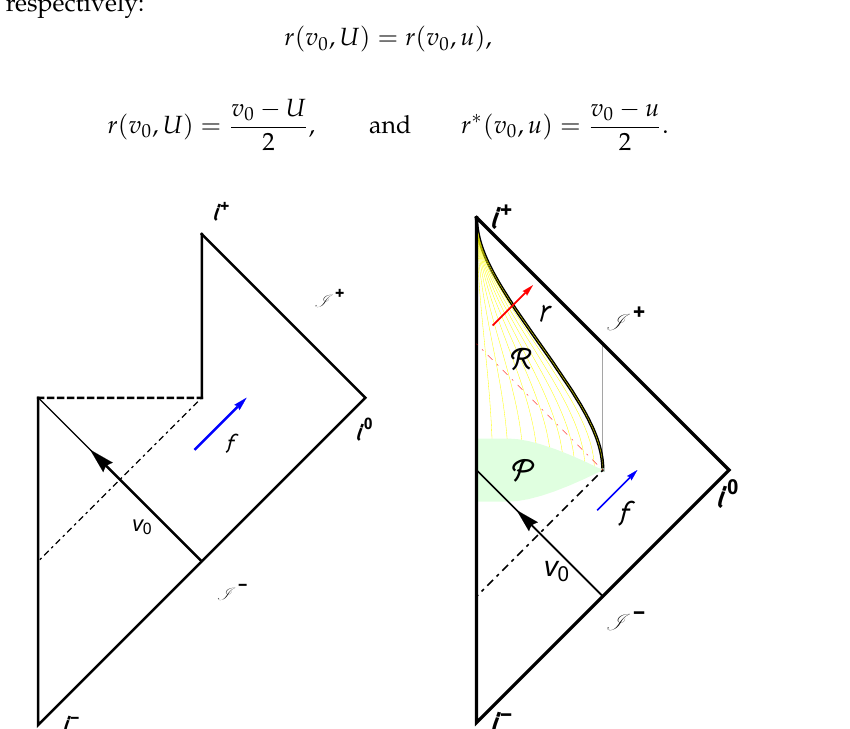
Figure 1. ( Left ) The usual Penrose diagram for an evaporating Schwarzshild black hole with a singularity (thick dashed horizontal line) and information loss. The dotted dashed line is the event horizon. The outgoing blue arrow, f , is the Hawking flux and the ingoing black arrow, v 0 , is the shock wave. ( Right ) Penrose diagram for the 3 + 1 dimensional case where a black hole remnant remains with infinite lifetime (for a similar diagram, see [10]). Notice the redshifted outgoing modes, labeled as r with a red arrow, escape to null-infinity I + . Even though Hawking evaporation stops, all field modes passing through the remnant undergo an eternal late-time redshift after passing through and out of the remnant region R . The light green area labeled P is the Planckian region where quantum geometric effects are important (discontinuity) and has a non-zero, maximum, finite height centered at r = 0. All field modes can “reflect” off of r = 0 and pass through the R region without loss of